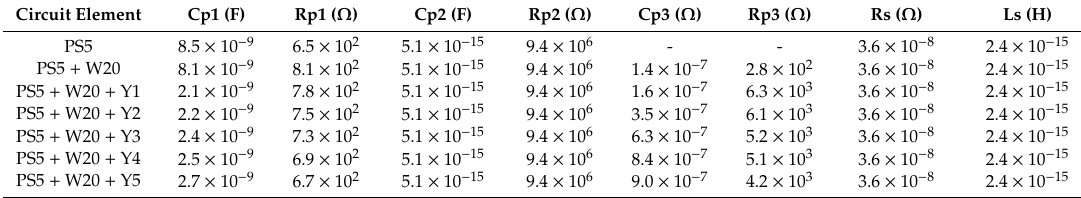
Table A6. Modeled impedance parameters Cp1, Rp1, Cp2, Rp2, Cp3, Rp3, Rs, and Ls of biochip PS5, with DI water and S. cerevisiae .